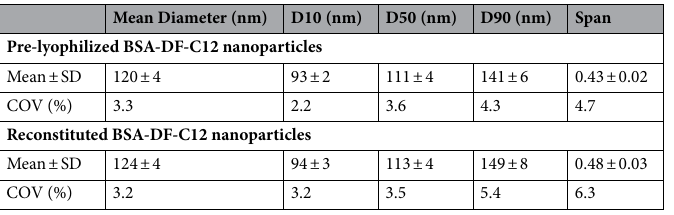
Table 2. Nanoparticle tracking assessment of BSA-DF-C12 and freeze dried/reconstituted BSA-DF-C12 nanoparticles from multiple fabrication lots (5). SD standard deviation of the mean.